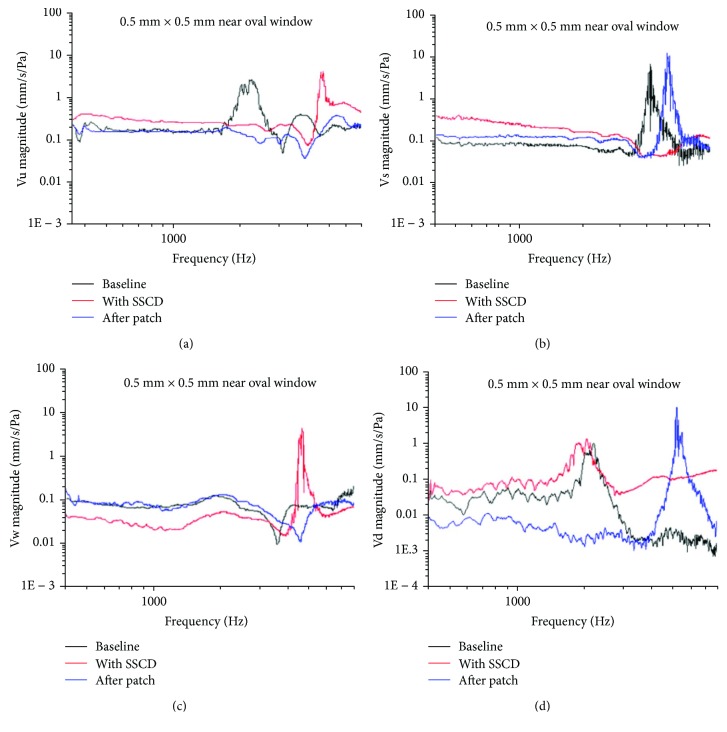
Vibration of the tympanic membrane (a), stapes head (b), round window (c), and the dehiscence (d), detected by LDV presurgery (black baseline) and postsurgery (red line) and after the dehiscence was repaired (blue line) (n = 6). (a) The presence of dehiscence (red line) statistically significantly (P < 0.006) increased the vibration of the tympanic membrane, in the range of 300–1500 Hz. The increase showed an offset after the dehiscence was repaired after surgery (blue line). (b) The presence of the dehiscence (red line) increased the vibration of the staples head, whereas it decreased the inner ear impedance statistically significantly (P < 0.001) in the range of 300–3000 Hz. This increase showed an offset after the dehiscence was repaired. (c) The presence of the dehiscence (red line) decreased vibration in the round window membrane statistically significantly (P < 0.001), in the range of 300–3000 Hz, which was offset after the dehiscence was repaired (blue line). (d) The vibration of the dehiscence located at the superior semicircular canal increased statistically significantly (P < 0.001) after the dehiscence was created, in the range of 300–2000 Hz. This increase showed an offset after the dehiscence was repaired.